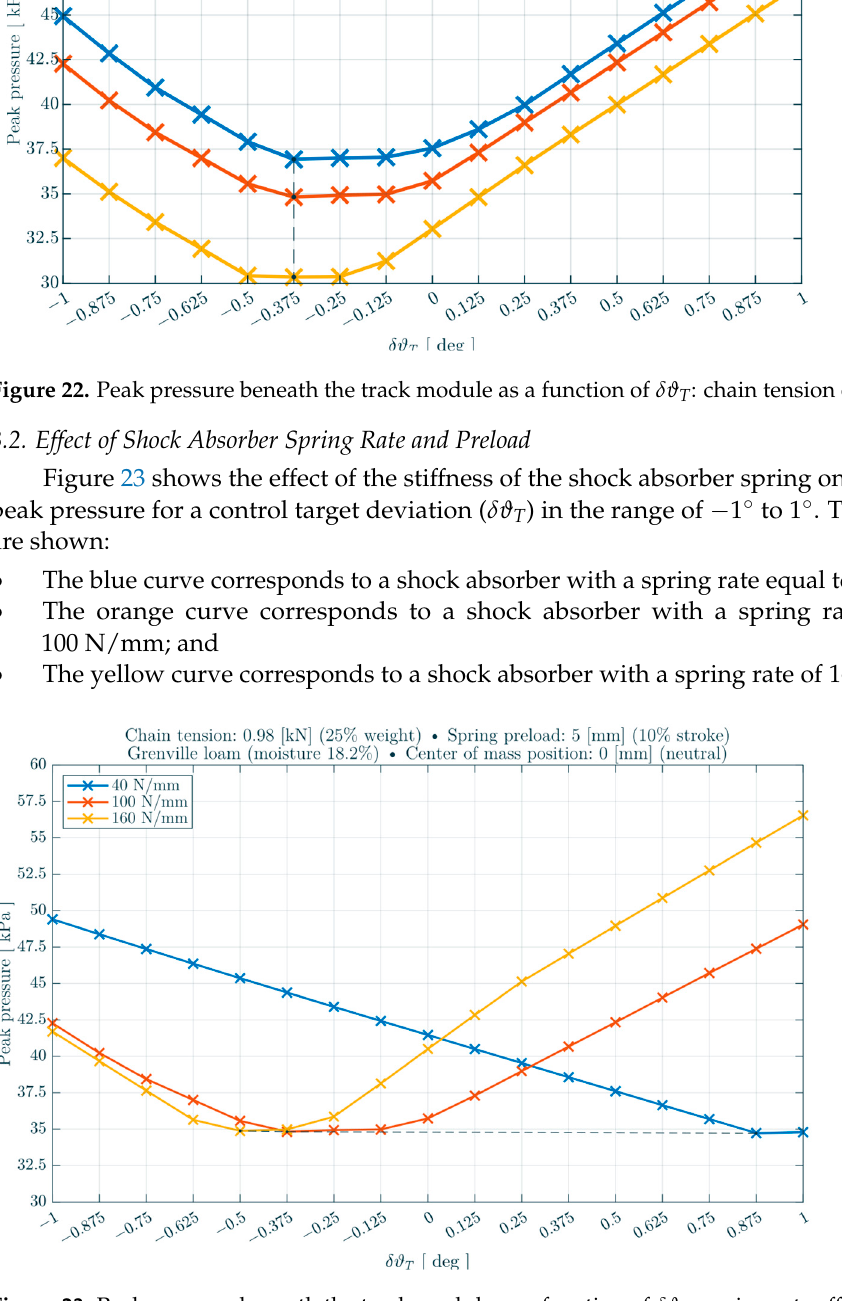
Figure 23. Peak pressure beneath the track module as a function of δϑ T : spring rate effect. The above-listed alternatives cover a wide range of elasticity, from a soft spring to the hardest one. All three curves exhibit a minimum point corresponding to different δϑ T values. The blue curve reaches the minimum at δϑ T = 0.875 ◦ , whereas for the orange and the yellow curves, the minimum peak pressure is obtained at δϑ T = − 0.375 ◦ and δϑ T = − 0.5 ◦ , respectively. Such differentiations are easily understood by considering that the shock absorber and the ground can be thought of as two springs in series, with stiffnesses of k S and k G , respectively, so the overall stiffness is defined as in (54) 𝑘 𝑘 (cid:3046) (cid:3034) 𝑘 = (54) Equation (52) shows that if a certain force is to be developed on a given terrain, the softer the spring (the lower k S ), the further the control system has to push the idler to achieve a minimum peak pressure (the higher the δϑ T ). An comparable result is obtained by varying the preload of the spring, as shown in Figure 24. Figure 24. Peak pressure beneath the track module as a function of δϑ T : spring preload effect.